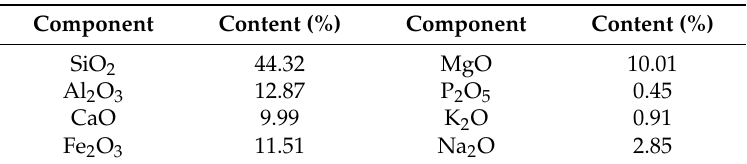
Table 1. Basalt powder